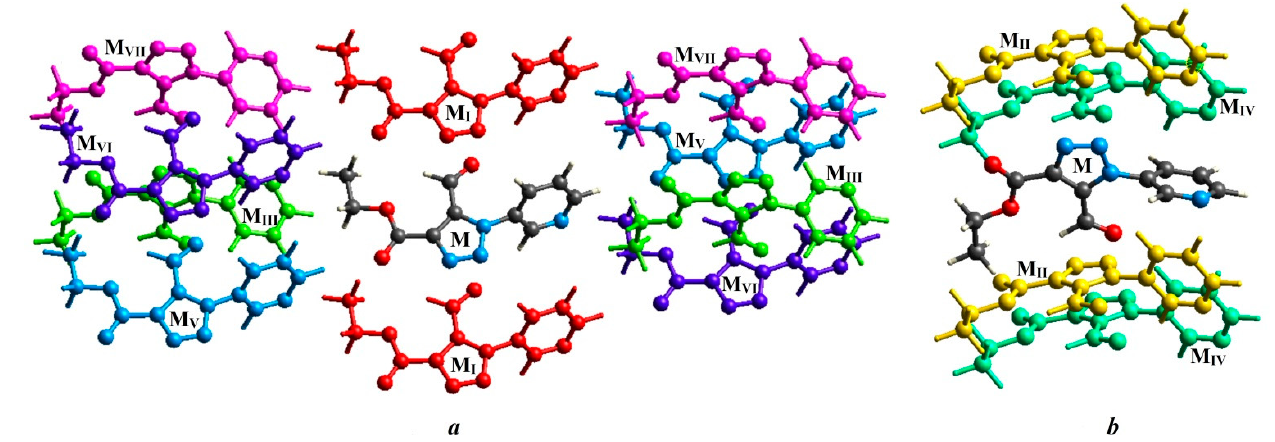
Figure 6. The principal interactions between molecules in 1 with numbering of two neighboring molecules (M I –M VII ) involved in the same interactions with the selected one (M). For better percep- tion, the molecules from the cluster are divided into two parts ( a and b ), represented at different crystallographic directions. Table 3. The intermolecular interaction energies (kJ/mol) in crystal structure of 4.